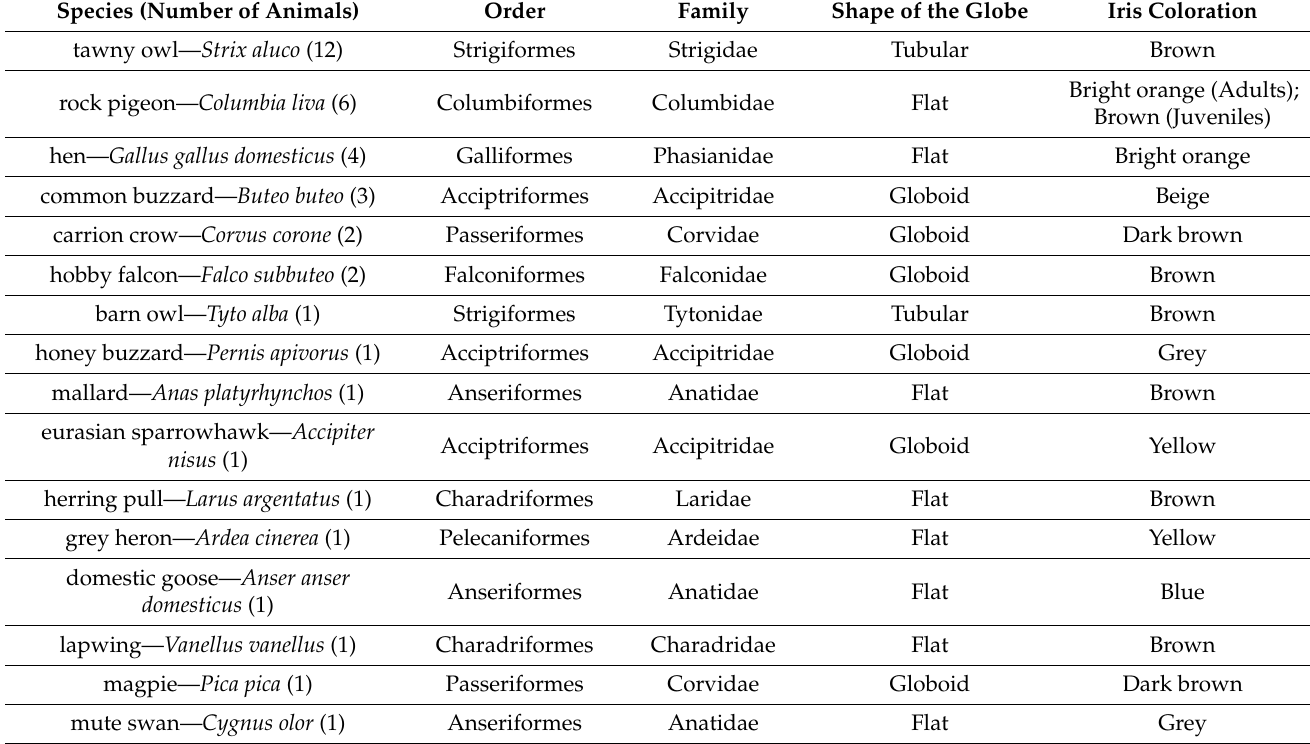
Table 1. Shape of the globe and iris coloration of avian species included in the study.